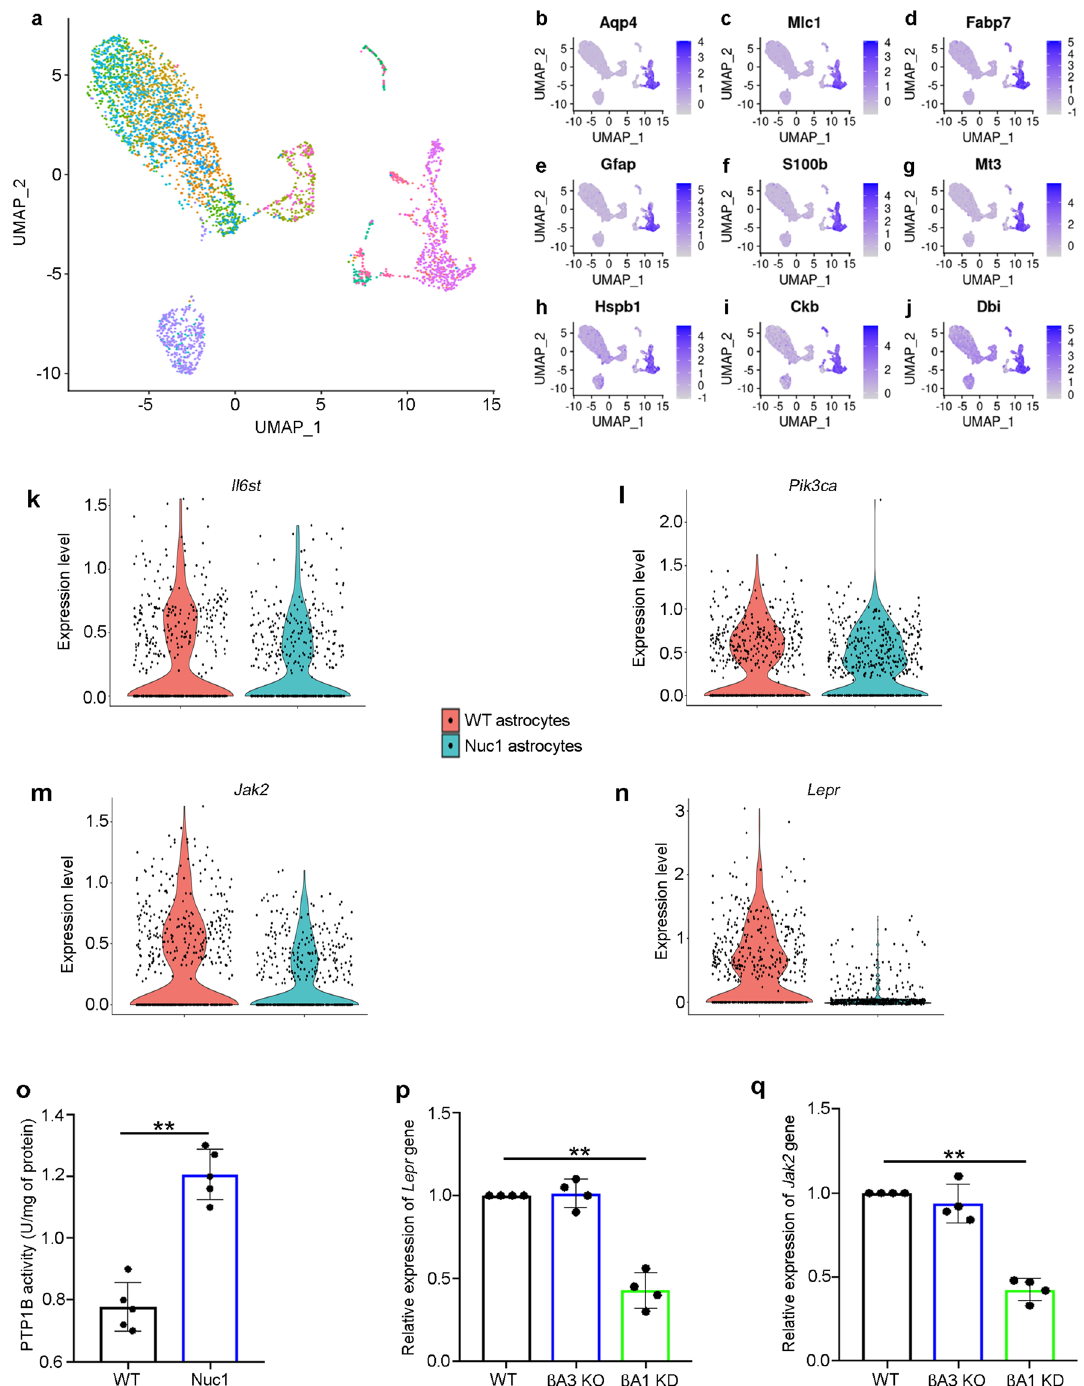
Fig. 5 β A1-crystallin regulates STAT3-dependent signaling in retinal astrocytes. Integrated analysis of single-cell transcriptomic data across WT and Nuc1 genotype. a T-distributed stochastic neighbor embedding (t-SNE) plot of mixed cell culture samples harvested from the optic nerve head of WT and Nuc1 rats, integrated into a single dataset and clustered using Seurat. b – j Feature plots of gene markers used to identify and annotate astrocyte cell clusters. k – n Gene expression patterns of k Il6st , l Pik3ca , m Jak2 , and n Lepr in WT and Nuc1 astrocytes displayed as violin plots. o Elevated PTP1B activity in cultured Nuc1 astrocytes, relative to WT. n = 4. P < 0.01. p , q qPCR analyses showing decreased expression of STAT3-dependent genes, p Lepr and q Jak2 in cultured mouse β A1 KD astrocytes compared to WT cells. Astrocytes from mouse β A3 KO did not show any change in the expression of p Lepr and q Jak2 genes, compared to WT cells. n = 4. P <